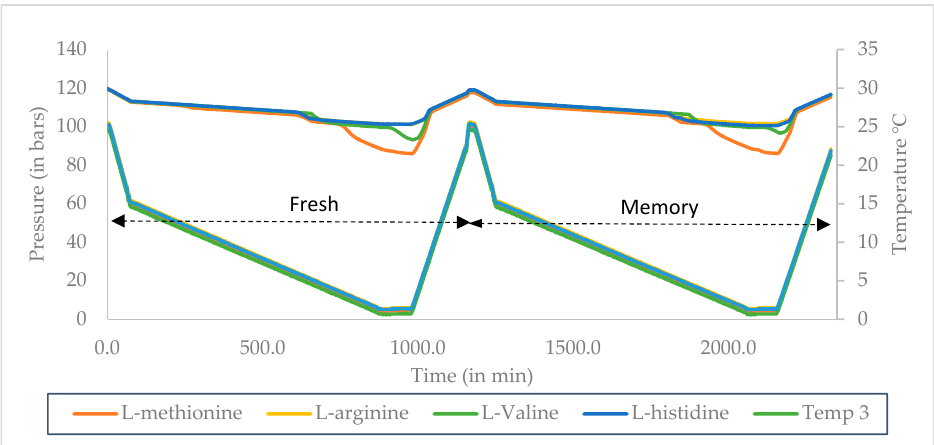
Figure 2. Flue gas (30 mole% CO 2 ) hydrate formation in the presence of amino acids: P-T variation during constant ramping scheme for selected amino acid during flue gas hydrate formation with 30% CO 2 .